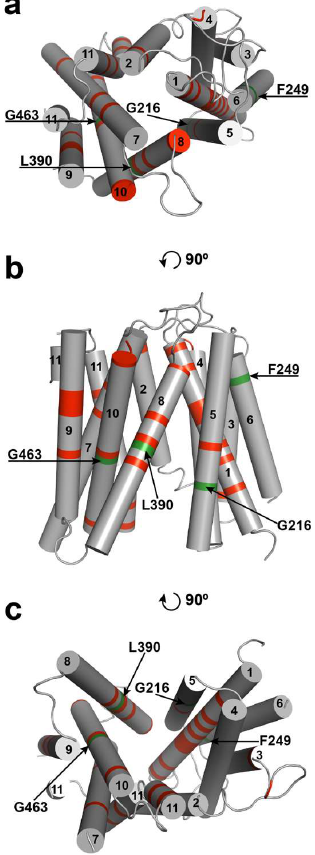
Figure 3. Inward-open model of ScENT1 structure. Strictly conserved residues are denoted in red (~16% of total sequence). Residues functionally characterized using ScENT1 PLs are denoted in green and highlighted by arrows. Helix numbering is shown as 1–11 beginning with the N-terminus, and helix 11 is shown as discontinuous. ( a ) top-down view of structure (cytoplasmic side), ( b ) side view—lipid bilayer not depicted, and ( c ) bottom-up view of structure (luminal side). Panel a and panel c are simple rotations of 90 degrees relative to b